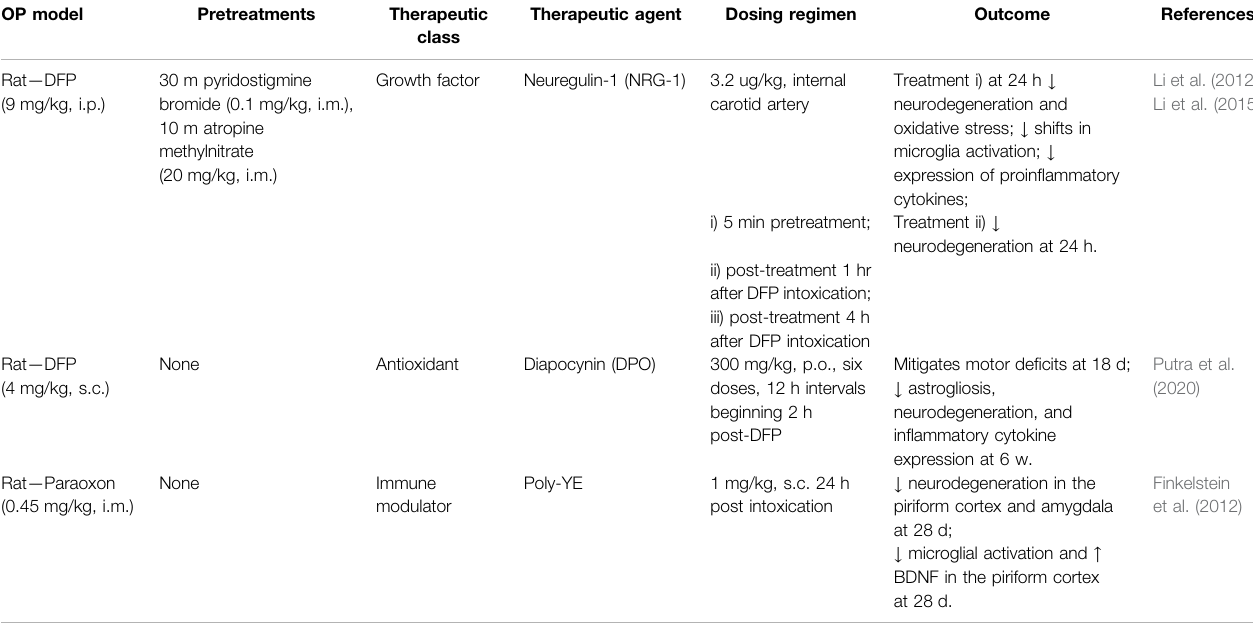
TABLE 1 | ( Continued ) Effects of anti-in fl ammatory therapeutics in OP